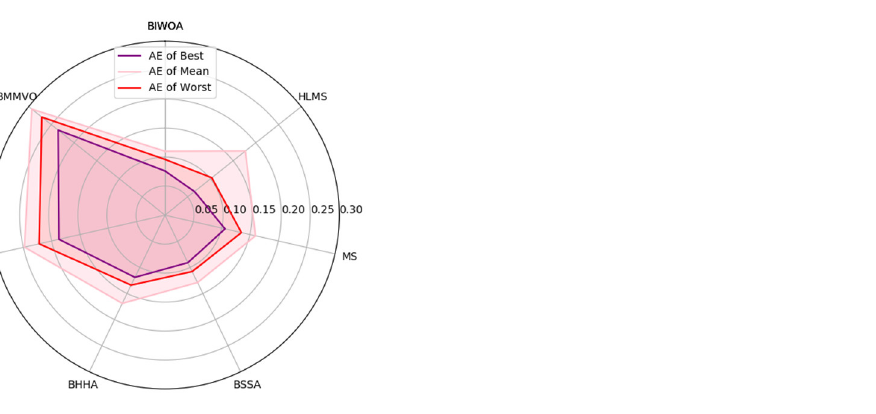
Figure 11. Boxplot for 5 parameter combinations on SR for Test set I